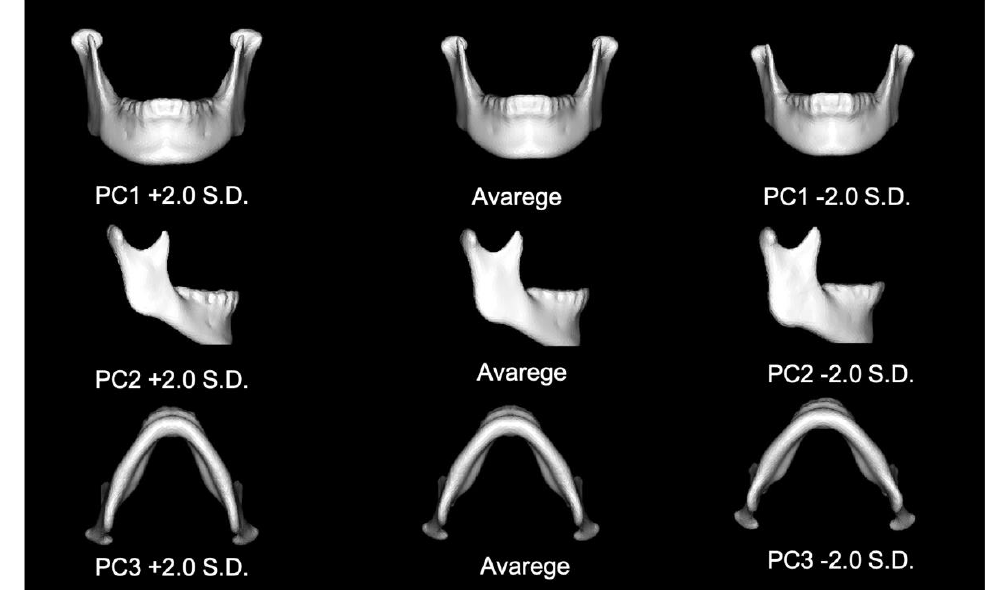
Figure 2. The figure of PC 1, 2 and 3 in total mandible.